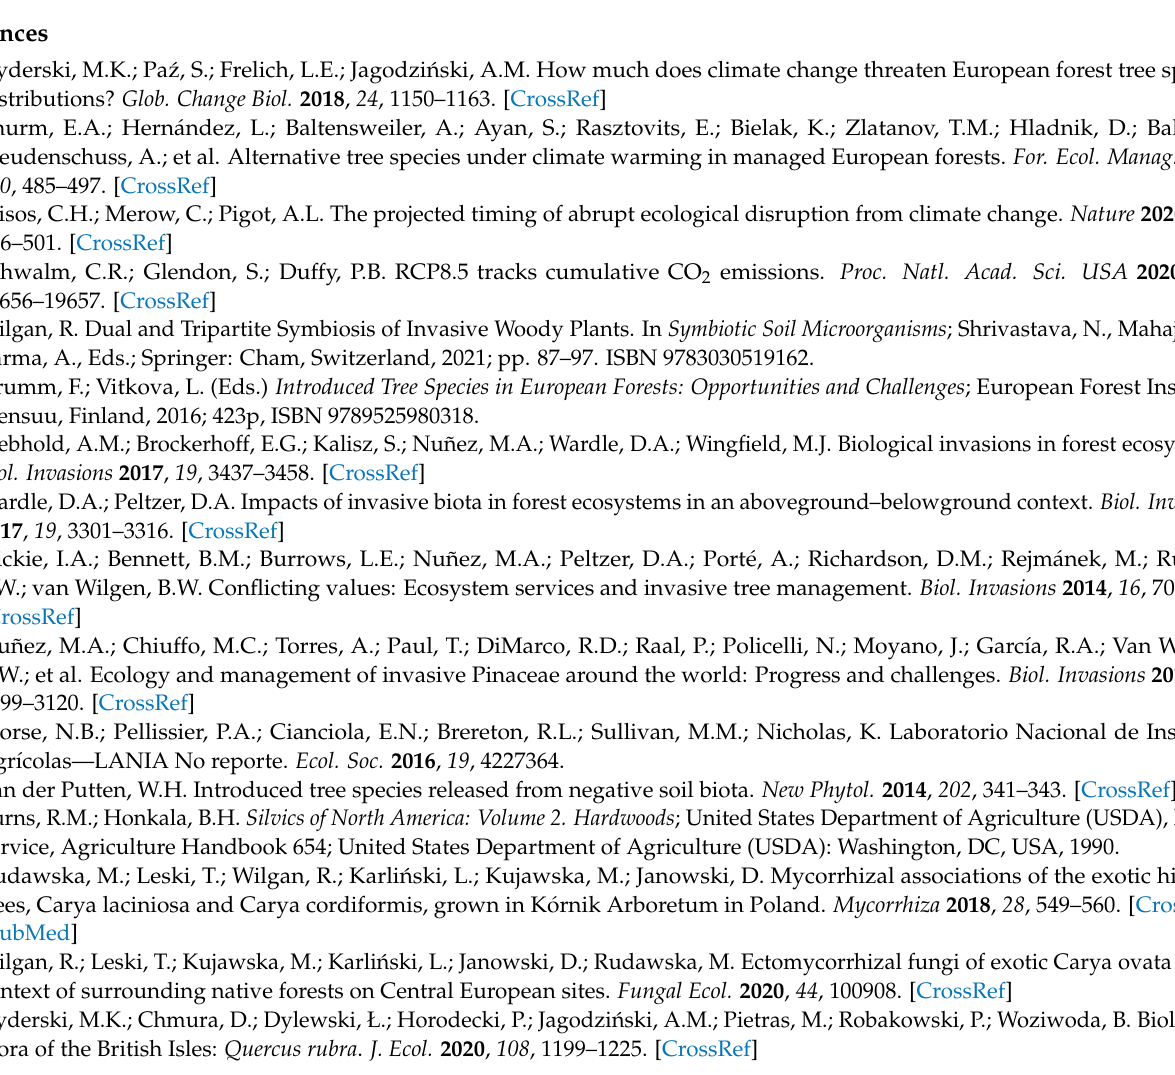
Table S1: The frequency of ECM phylogenetic lineages on the roots of tested